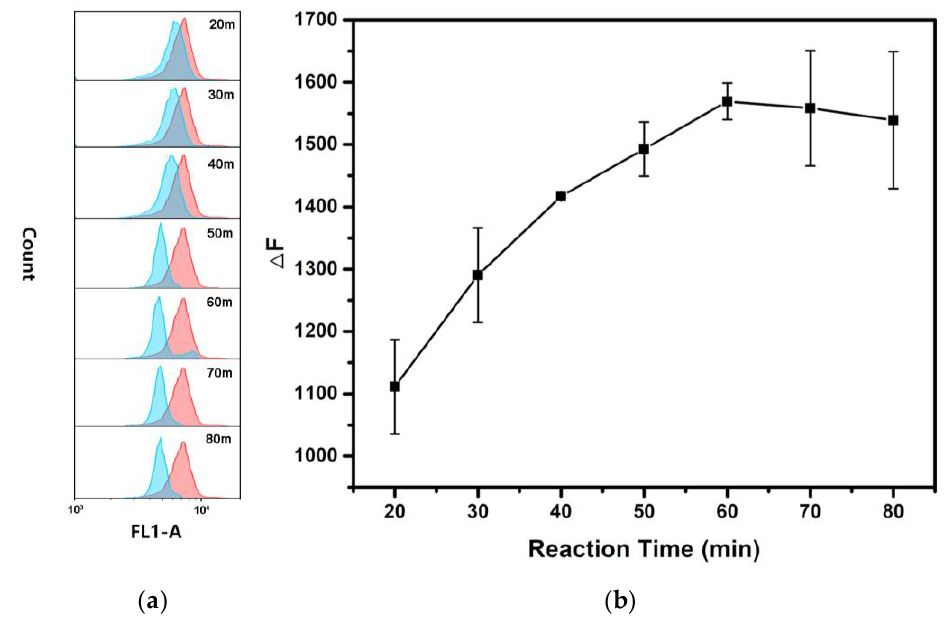
Figure 3. Effect of the reaction time on the detection of hsa-miR-146b-5p: ( a ) fluorescence re- sponses of the MB@dsDNA treated with 100 pM hsa-miR-146b-5p (blue lines) and blank control (red lines) at 37 °C under different reaction times (20, 30, 40, 50, 60, 70 and 80 min), respectively; ( b ) the corresponding relative fluorescence intensity changes (ΔF) with different reaction times. error bars mean standard deviations ( n = 3).